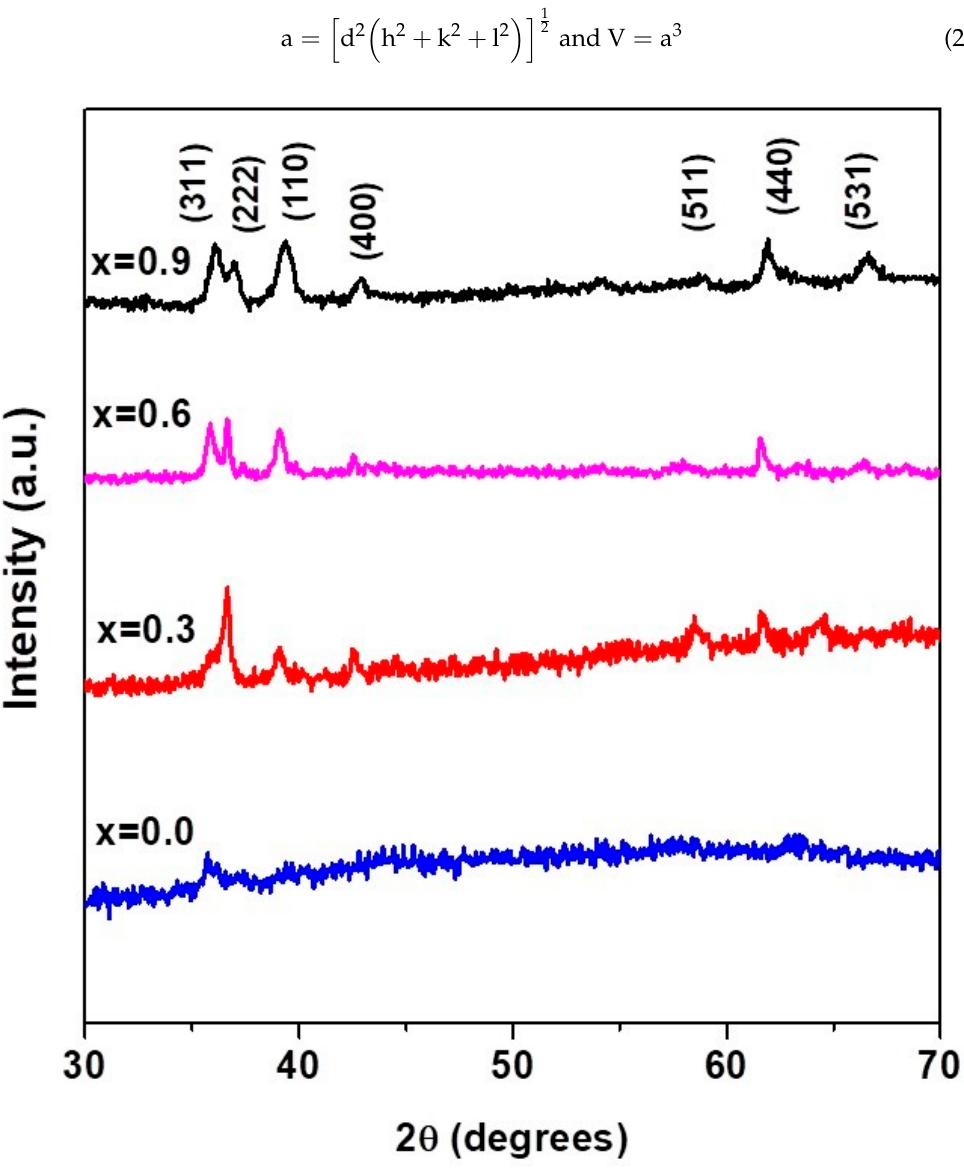
Figure 5. XRD pattern of copper-substituted, plant-extracted cobalt ferrite nanoparticles Co 1 − x Cu x Fe 2 O 4 (0 ≤ x ≤ 1): at x = 0.0; pure CoFe 2 O 4 , at x = 0.3; Co 0.7 Cu 0.3 Fe 2 O 4, at x = 0.6; Co 0.4 Cu 0.6 Fe 2 O 4 and at x = 0.9; Co 0.1 Cu 0.9 Fe 2 O 4 .